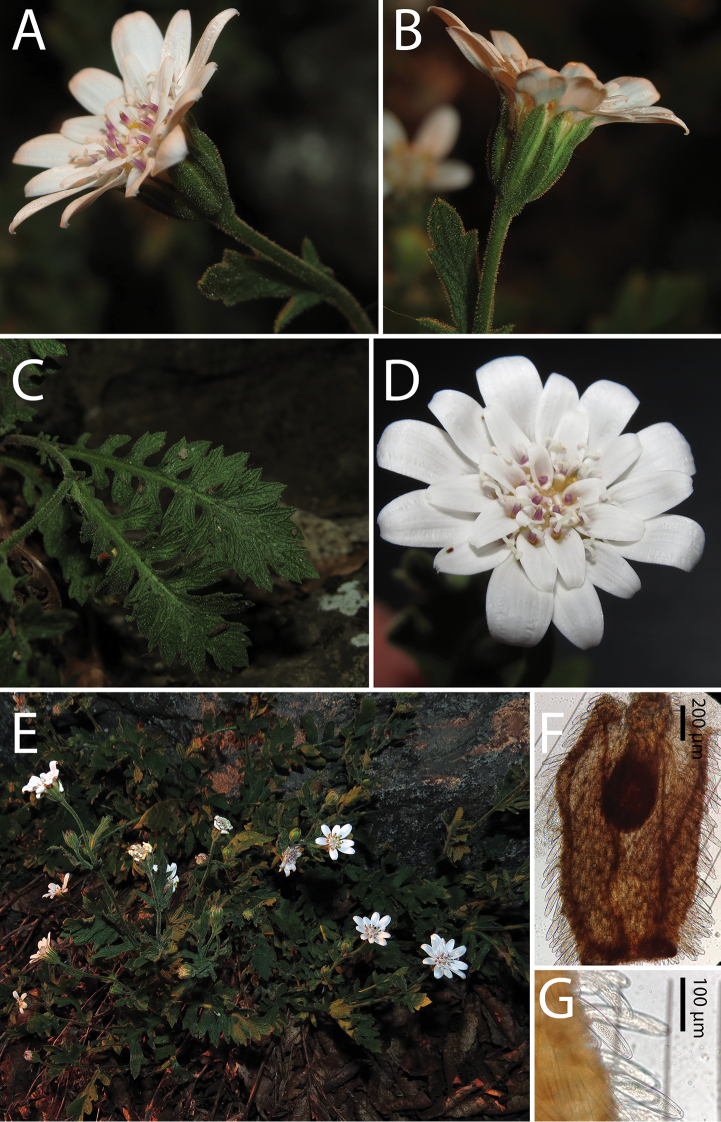
Leucheria
cantillanensis Lavandero, sp. nov. A capitulum, sideways view B capitulum, detail of Middle involucral bracts C leaves D capitulum, upper view E plants growing in natural habitat F cypsela G detail of trichomes in cypsela. All photographs by Nicolás Lavandero.